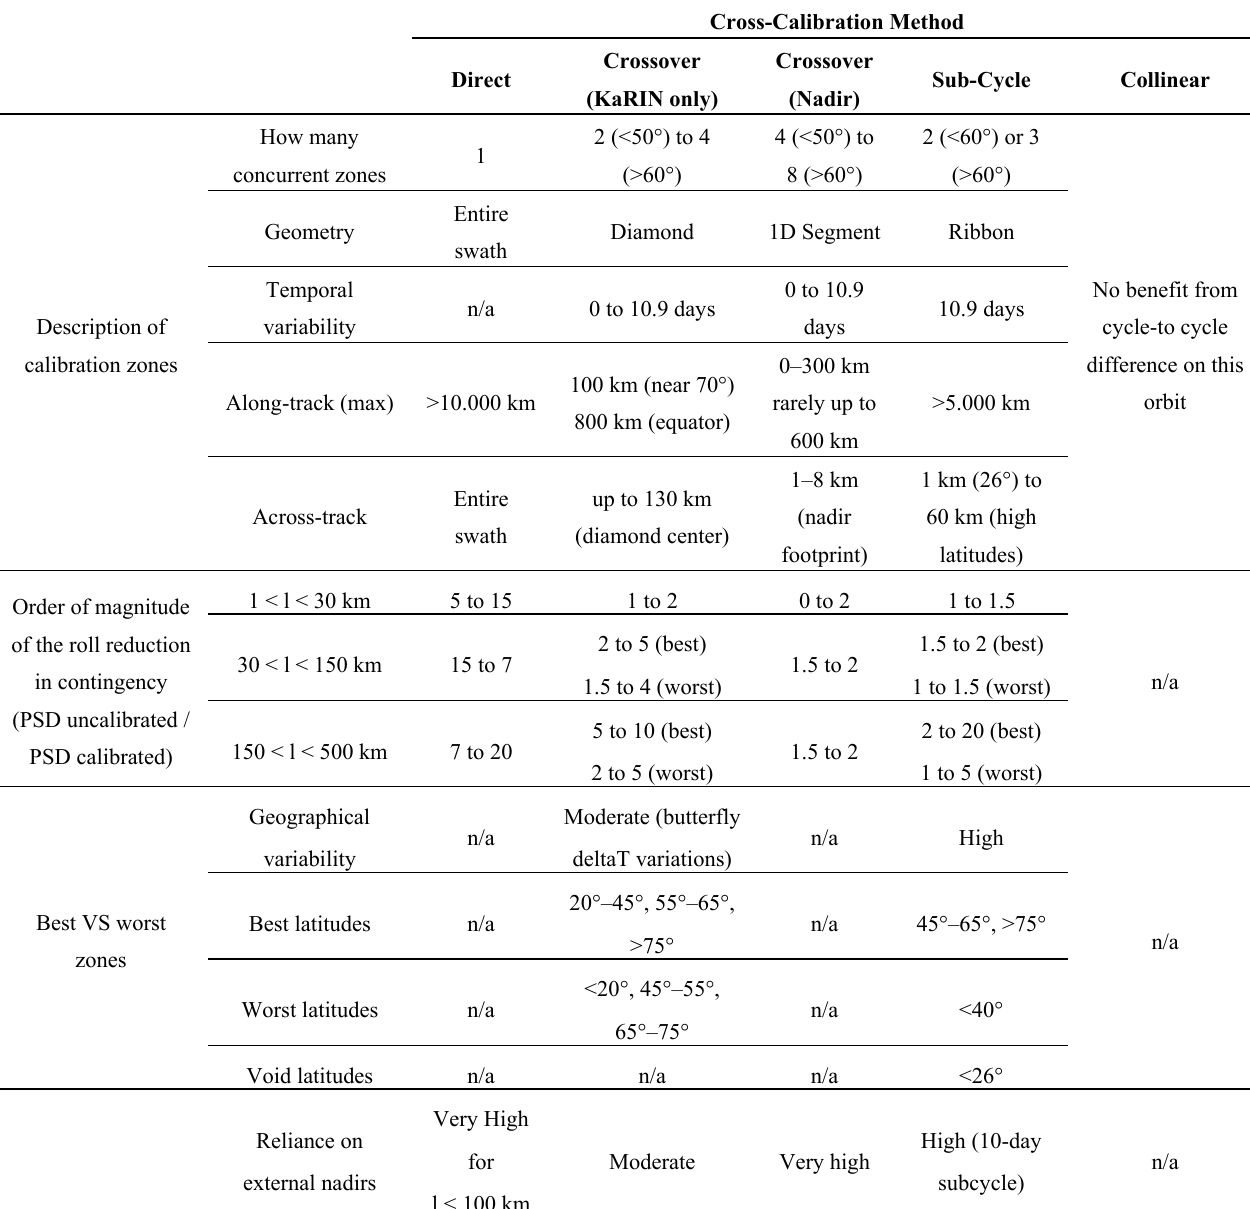
Table 1. Synthesis for baseline orbit (21-day repeat, 10-day